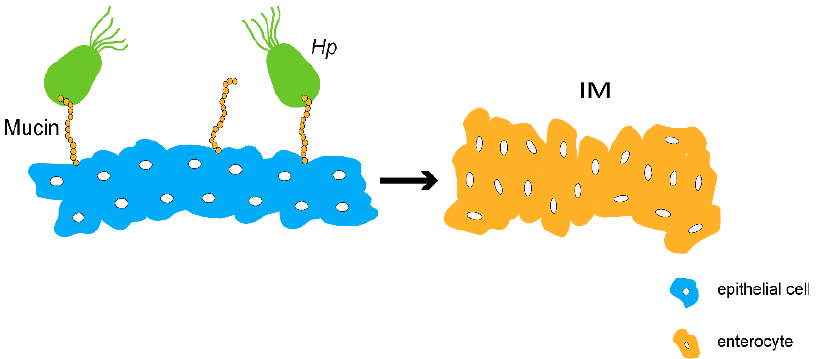
Figure 3. Abnormal mucin expression causes Hp to colonize the gastric epithelium, resulting in Intestinal epithelial metaplasia (IM) of the gastric mucosa. Mucins are highly glycosylated glycoproteins. Some mucins, such as MUC5Ac, are an important component of the gastrointestinal mucosal defense system, which protects the gastric surface from chemical, enzymatic, mechanical, and microbial damage. It is important that mucins carry glycan epitopes that provide binding sites for microorganisms, including the gastric oncogenic bacterium Hp .